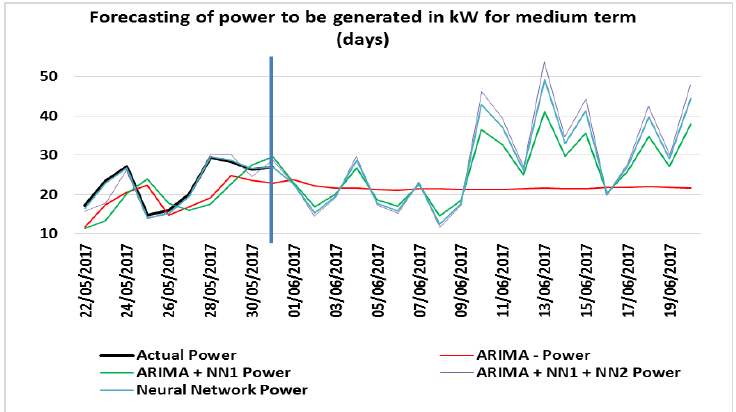
Figure 13. Power Generation Predicted for medium term (days) in kW.